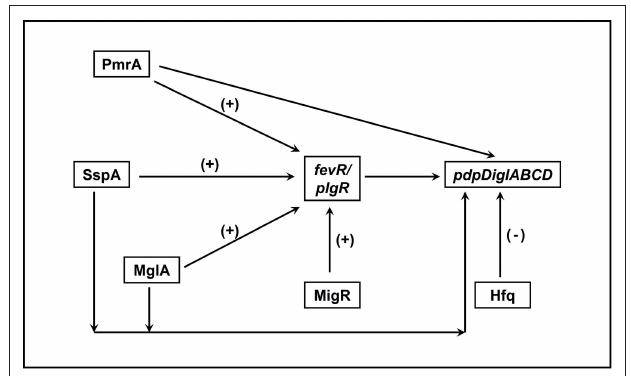
FiGUrE 1 | interactions between transcriptional regulators of Francisella that control FPi gene expression. PmrA, SspA, MglA, and MigR all positively regulate expression of fevR/pigR . The fevR/pigR product then plays a role, in conjunction with all of the other illustrated factors, in FPI gene transcription. PmrA, MglA, and SspA also directly regulate the genes of the FPI (see Figure 2 ). ( + ), Positive transcriptional regulation. ( − ), Negative transcriptional